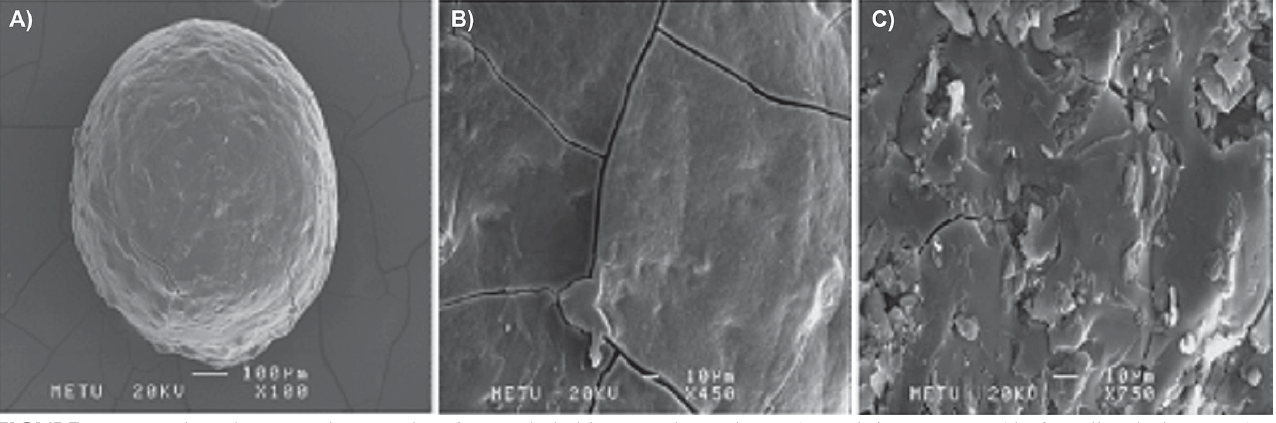
FIGURE 2 - Scanning electron micrographs of F6 coded chitosan microspheres (containing 30%FLB)before dissolution test (A, B) and its cross sectional micrograph (C).